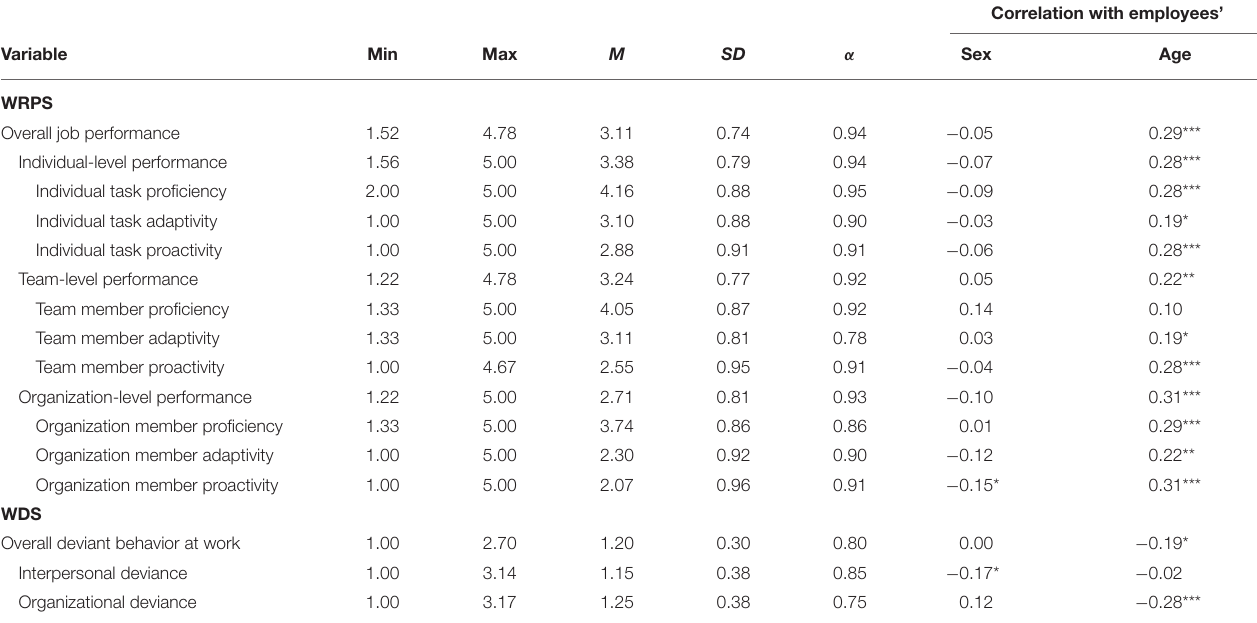
TABLE 3 | Supervisor ratings of employees’ productive and counterproductive work behavior: minima, maxima, means, standard deviations, Cronbach’s alpha coefficients of WRPS and WDS scales, and correlations between WRPS and WDS scales and employees’ sex and age.